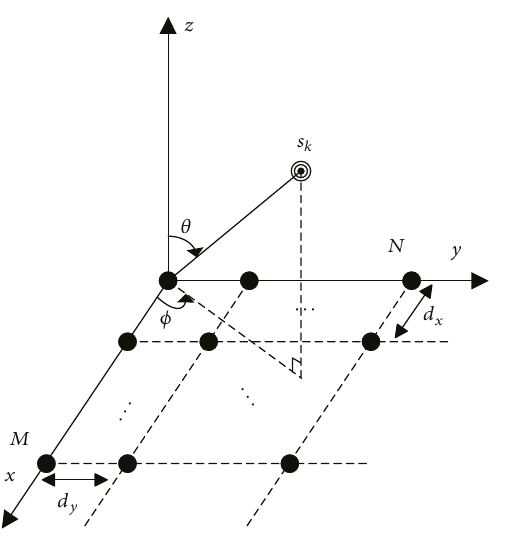
Figure 1: Array geometry of the